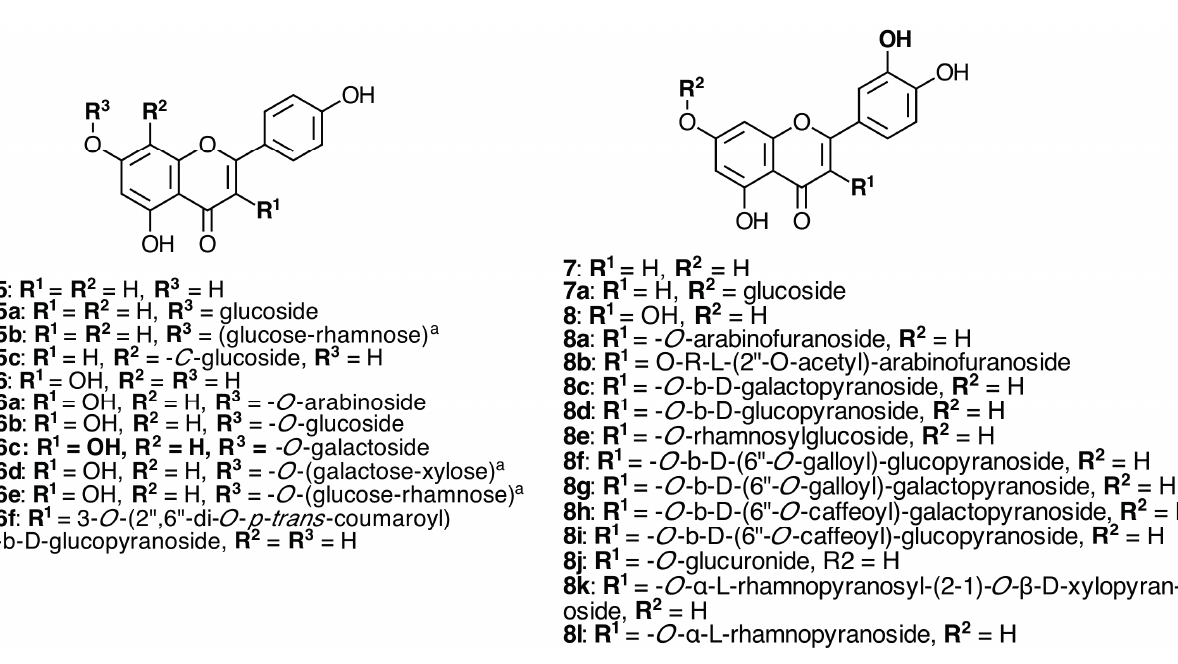
Figure 2. Apigenin, kaempferol, luteolin and quercetin derivatives isolated from Melastomataceae